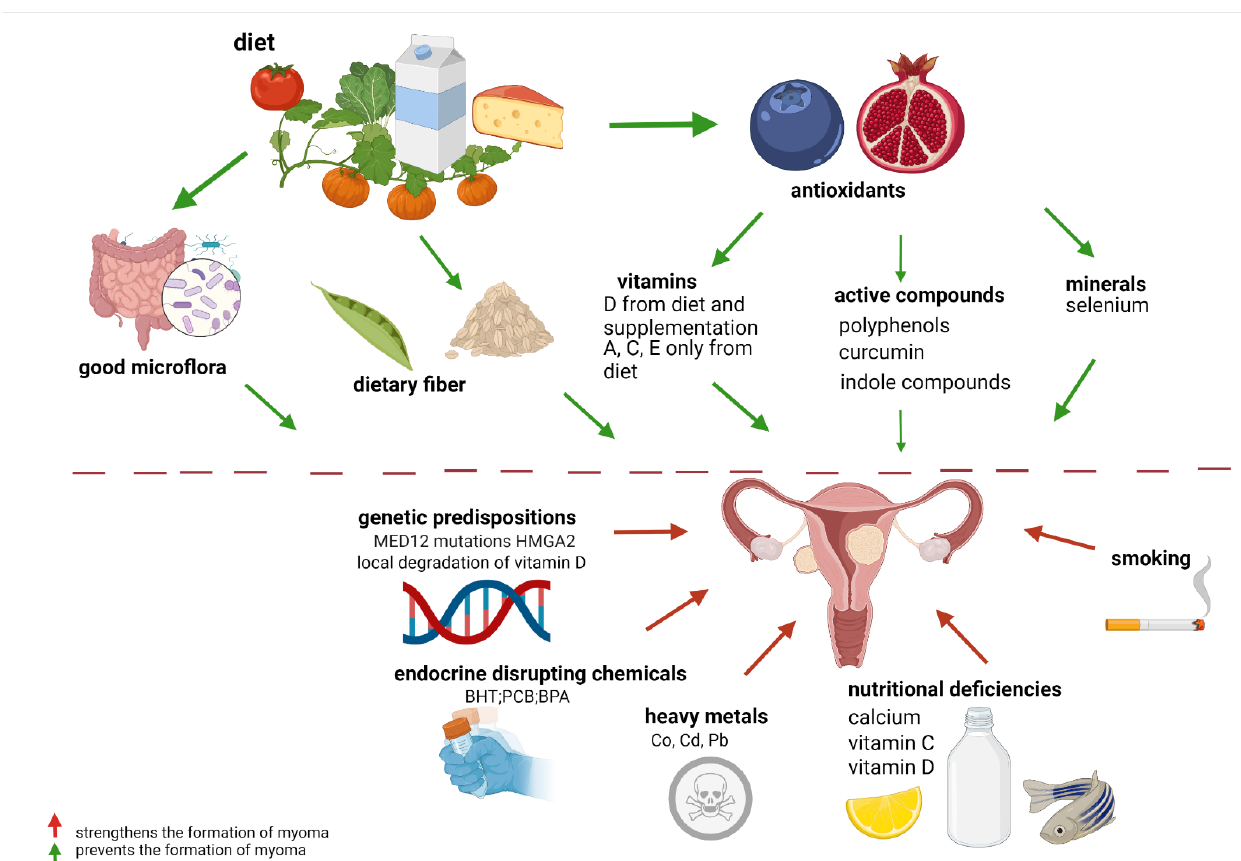
Figure 1. Effects of nutrients and environmental factors on leiomyoma. Legend: MED 12 mutations— mediator complex subunit 12; HMGA2—high mobility group AT-hook 2.; BHT—butylated hydroxytoluene; PCB—polychlorinated biphenyls; BPA—bisphenol A; Co—cobalt; Cd—cadmium; Pb—lead. (Created with BioRender.com https://app.biorender.com/, accessed on 30 November 2021). The link between Vitamin D deficiency and the risk of UFs was strongly